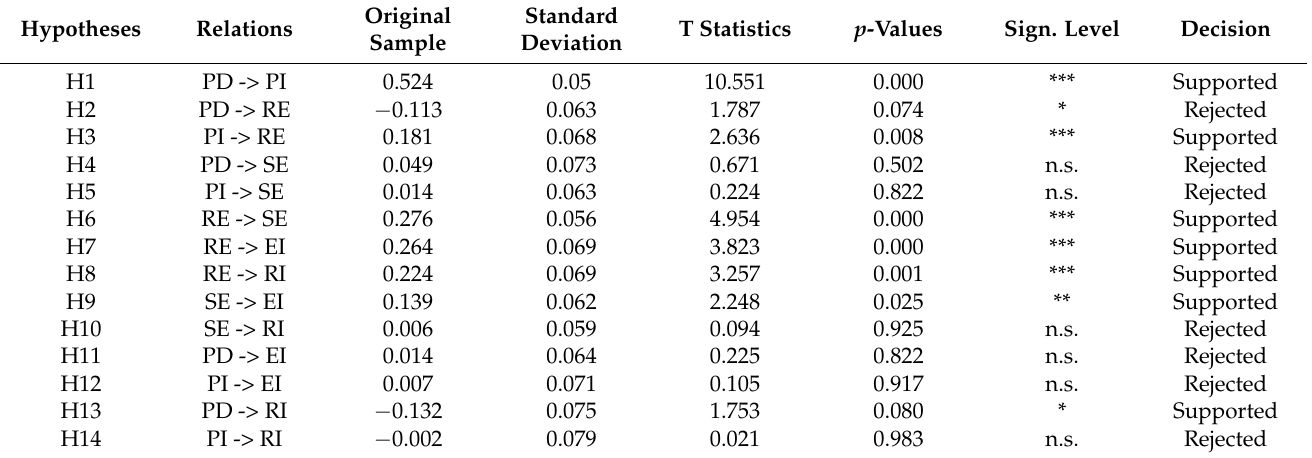
Table 5. Summary of hypotheses testing.